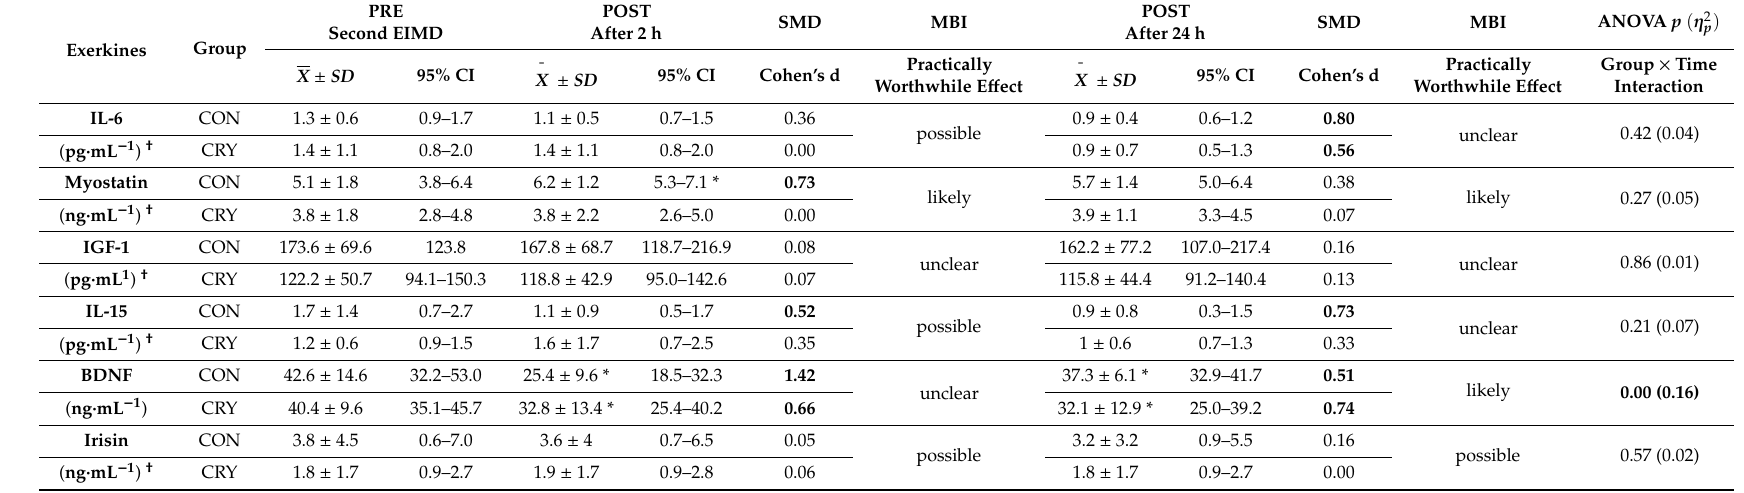
Table 1. Exerkines concentration before and after the second bout of exercise-induced muscle damage performed after 4 weeks of resistance training combined with cryostimulation or passive